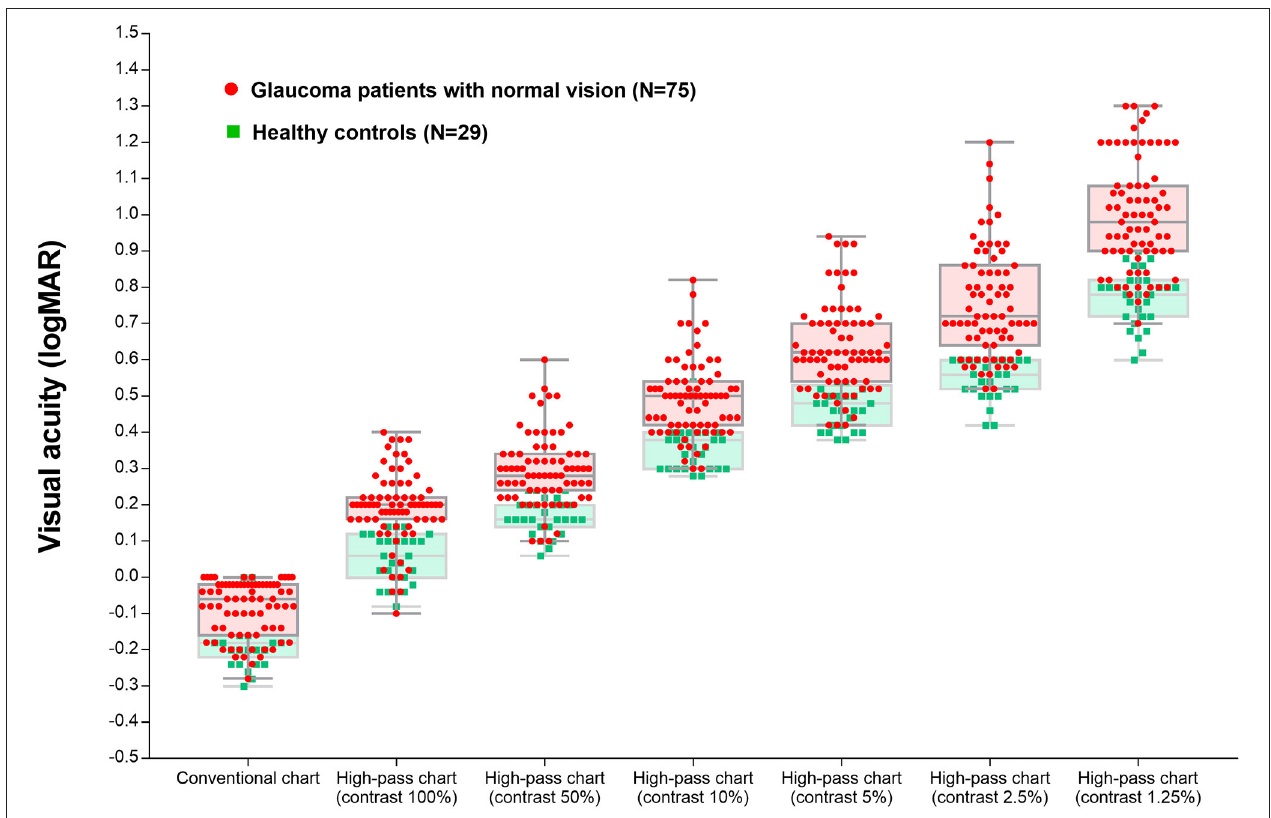
FIGURE 4 | Visual acuity measured using the conventional chart and high-pass charts at 100, 50, 10, 5, 2.5, and 1.25% contrast levels among glaucoma patients with normal vision and the healthy controls.